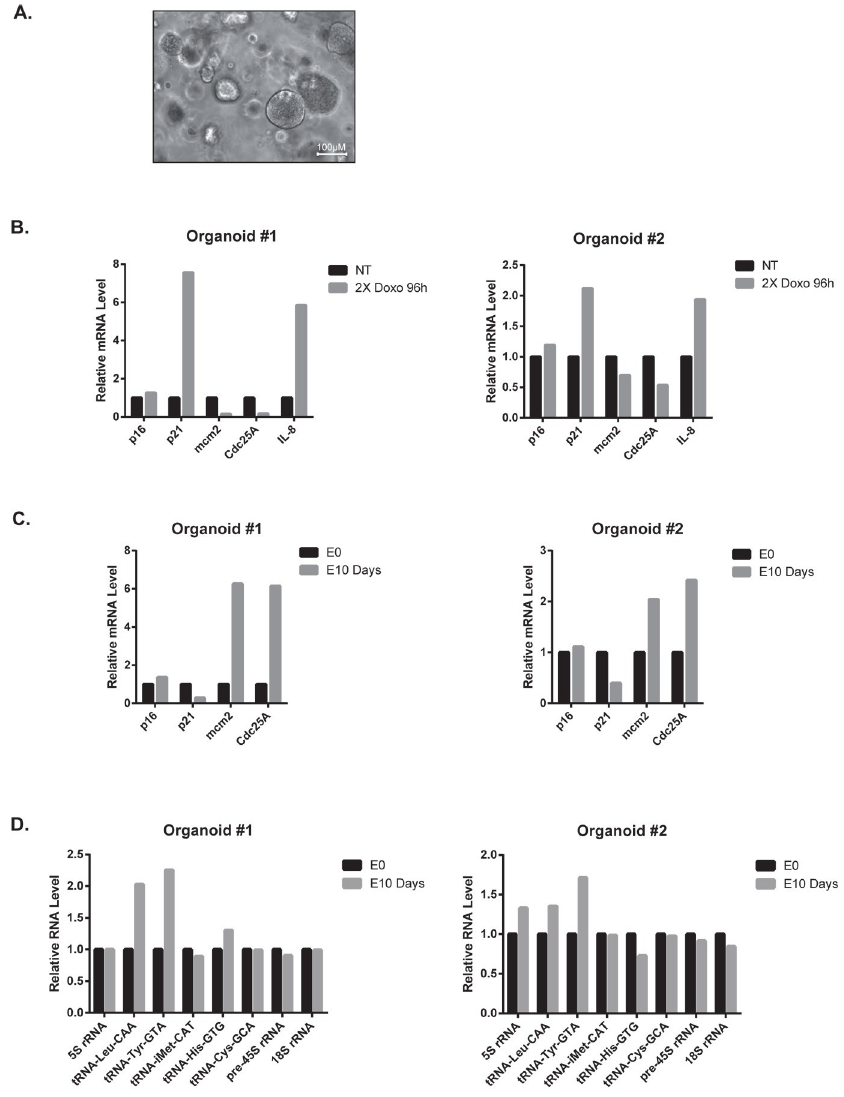
Fig 5. Up-regulation of the tRNA Leu -CAA and tRNA Tyr -GTA in breast organoids that escape chemotherapy. A. Representative image of breast cancer organoids. B. Analysis by RT-QPCR of proliferative and senescence markers of two breast tumor organoids treated or not with 2 cycles of 96 hr of Doxorubicin (All experiments were performed on two organoids coming from two patients, #1: Doxorubicin 25 ng/ml, #2: Doxorubicin 50ng/ml). C, D. Analysis of the expression of the indicated RNAs on PDOs at the end of the doxorubicin treatment (E0) and 10 days later (E10).